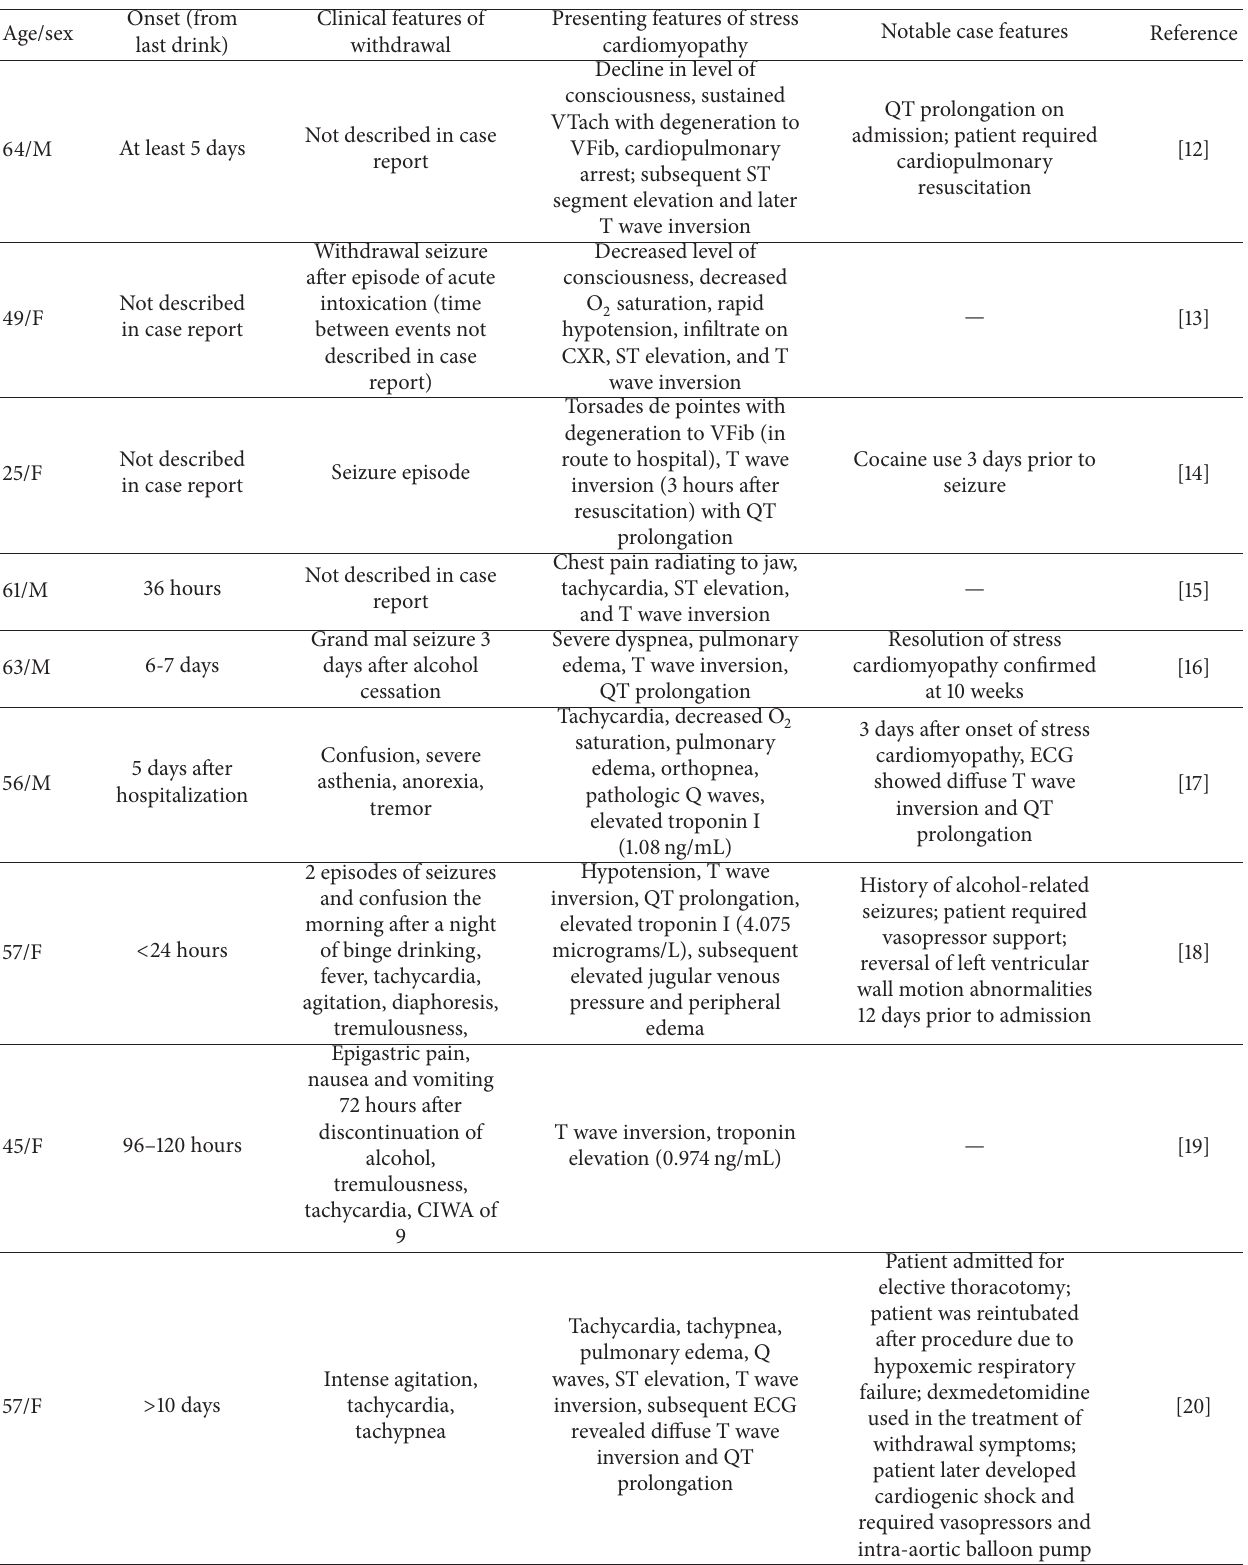
Table 1: Case reports of stress cardiomyopathy in patients with acute alcohol withdrawal. VTach, ventricular tachycardia; VFib, ventricular fibrillation; CXR, chest X-ray; CIWA, Clinical Institute Withdrawal Assessment of Alcohol